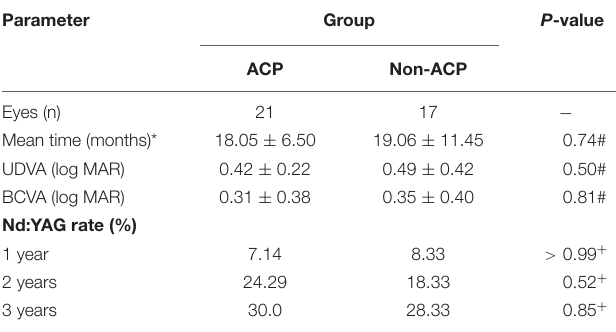
TABLE 2 | Preoperative patient characteristics.